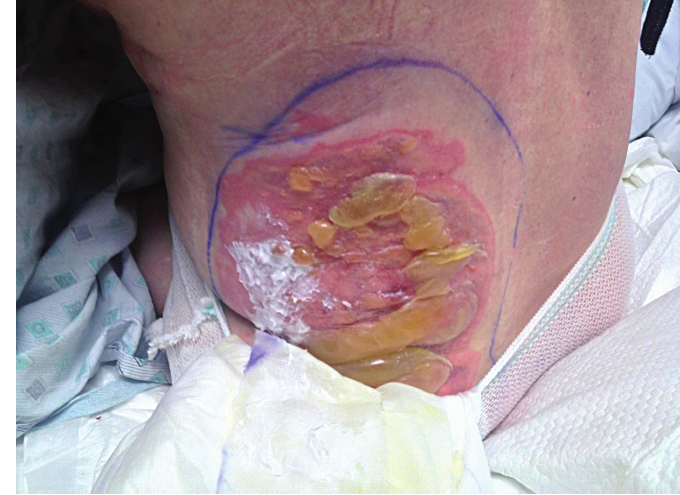
Figure 1 - Large raised erythematous area with superficial bullae seen on post-operative day